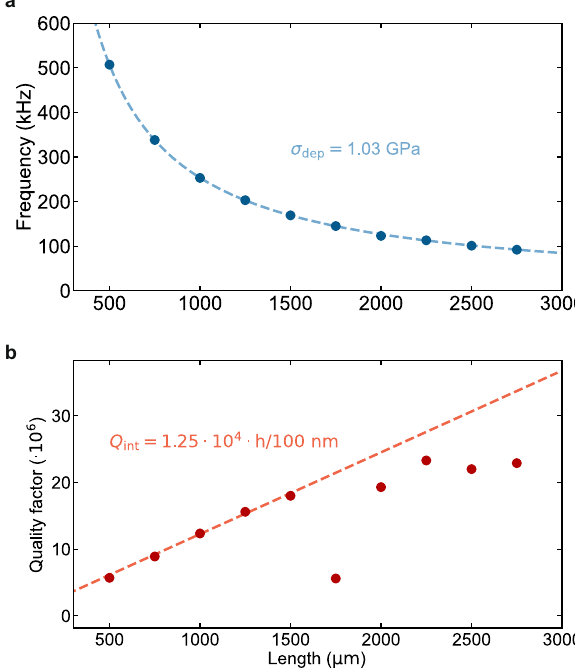
Fig. 5 Determination of mechanical parameters of Si 3 N 4 thin fi lms. a Frequency and b quality factors of uniform Si 3 N 4 beams of variable lengths.